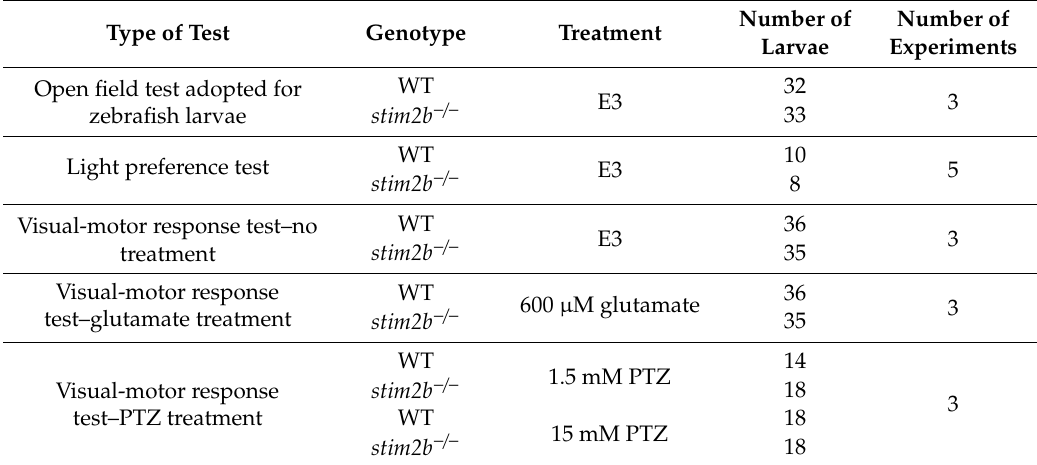
Table 1. Summary of numbers of animals and replications of experiments for all behavioral